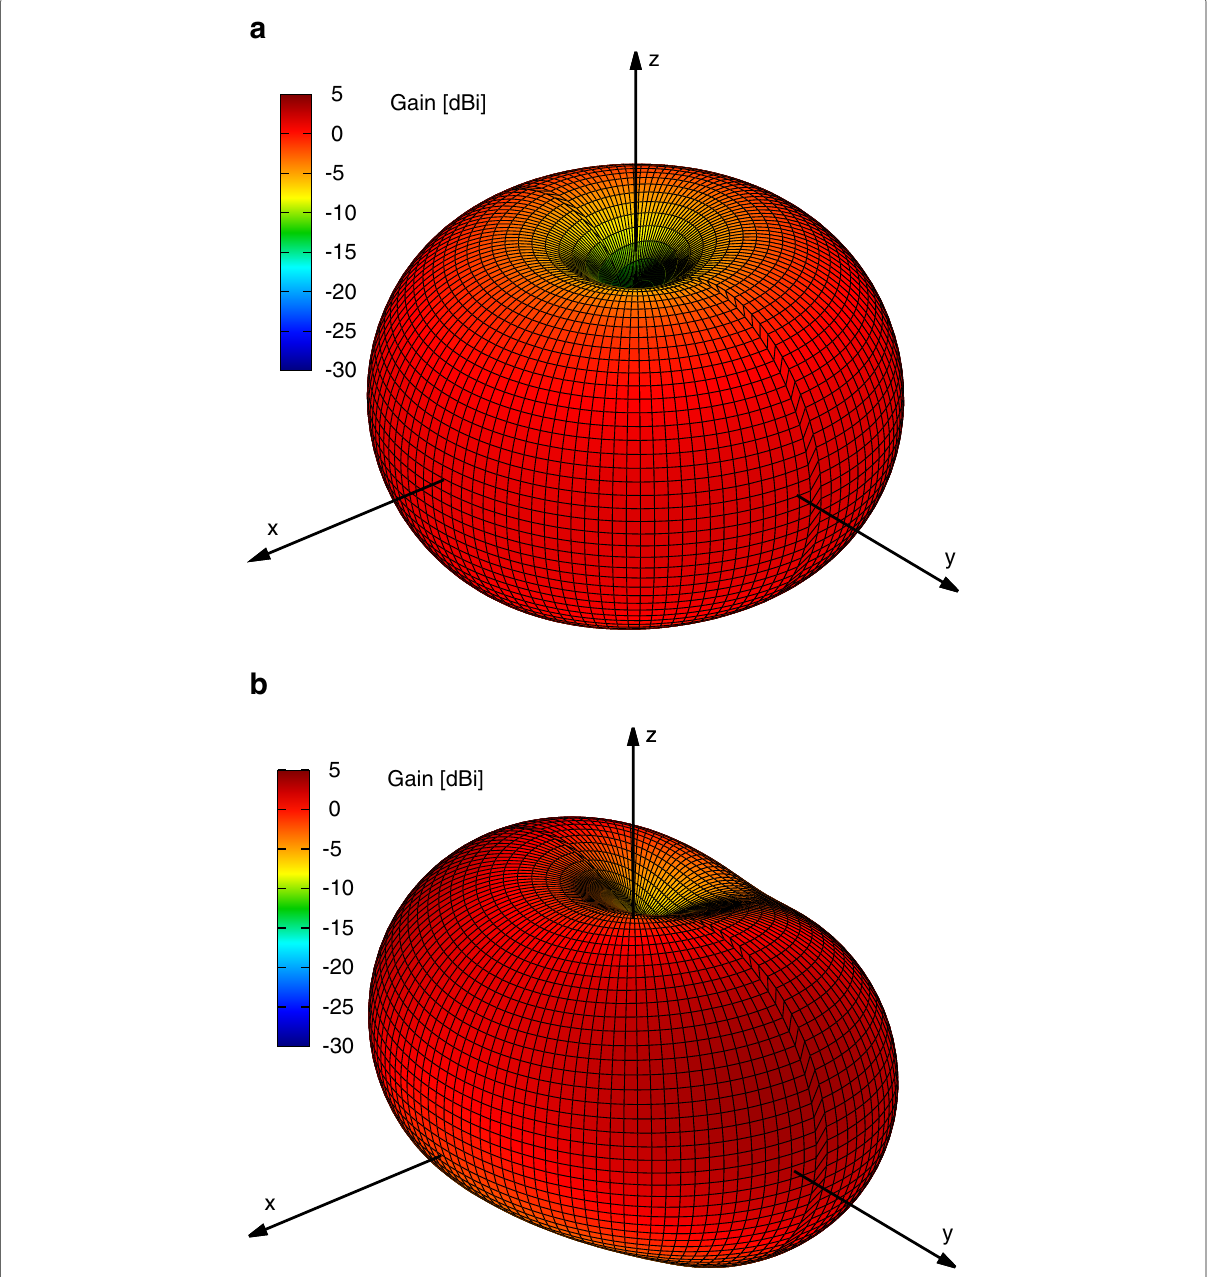
Fig. 6 SbD validation (LTE-2100 and LTE-3500 bands). Radiation pattern of optimized layout at a 2.045 GHz and b 3.5 GHz